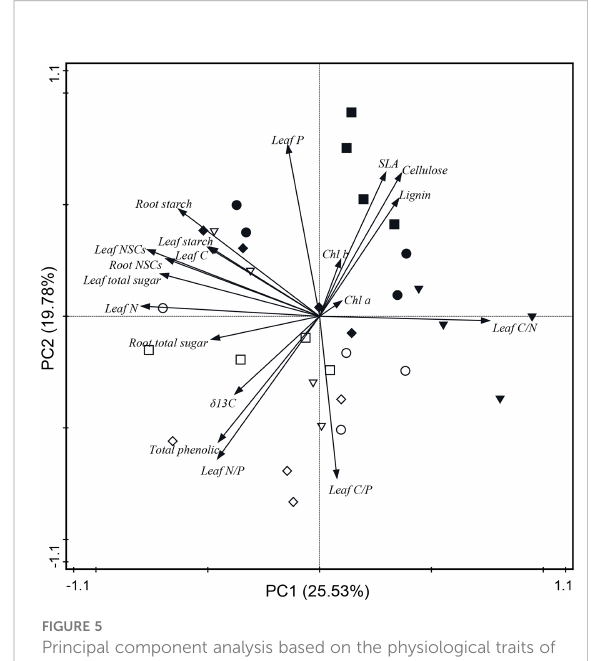
FIGURE 5 Principal component analysis based on the physiological traits of both Q. variabilis and L. formosana under canopy N and water additions. CK, control group; CN, canopy N addition; CW, canopy water addition; CWN, canopy N and water interaction; white circle, CK with Q. variabilis ; white inverse triangle, CN with Q. variabilis ; white diamond, CW with Q. variabilis ; white square, CWN with Q. variabilis ; black circle, CK with L. formosana ; black inverse triangle, CN with L. formosana ; black diamond, CW with L. formosana ; black square, CWN with L. formosana ; Chl a, chlorophyll a; Chl b, chlorophyll b; SLA, speci fi c leaf area; NSCs, non-structural